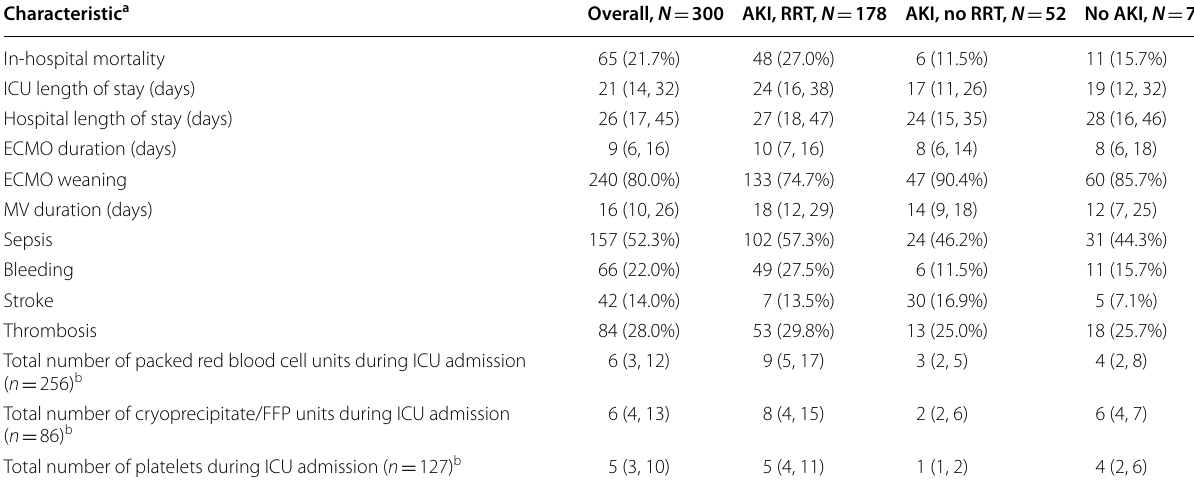
AKI acute kidney injury, ECMO extracorporeal membrane oxygenation, FFP fresh frozen plasma, ICU intensive care unit, MV mechanical ventilation, RRT renal replacement